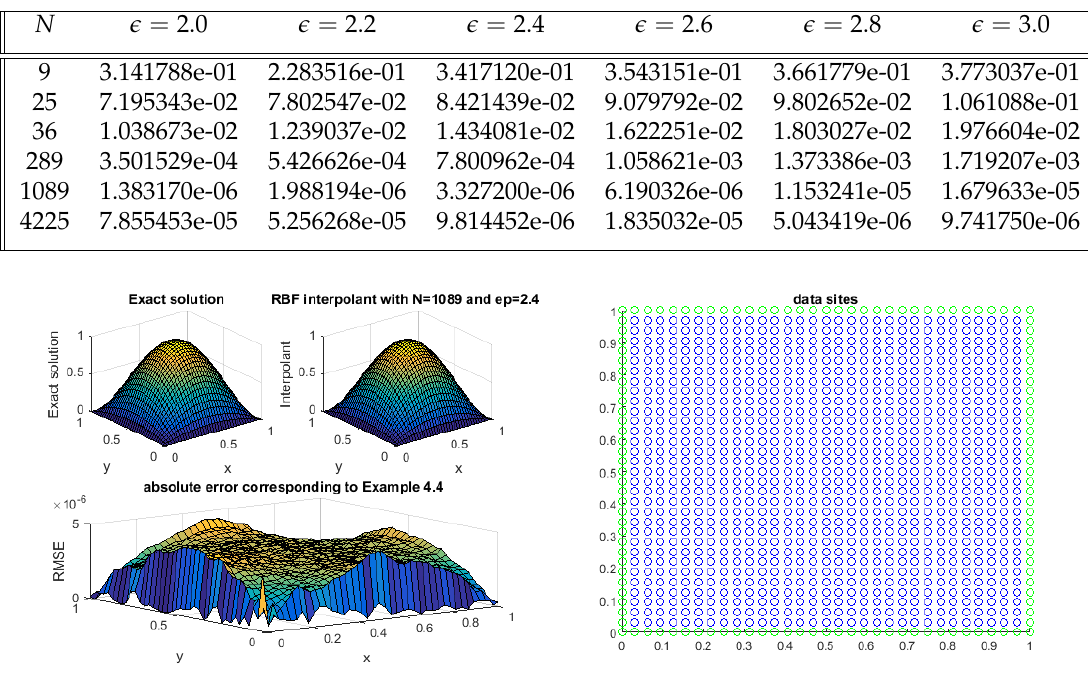
Table 5. RMSE for Example 4 over a range of shape parameter ( (cid:101) )